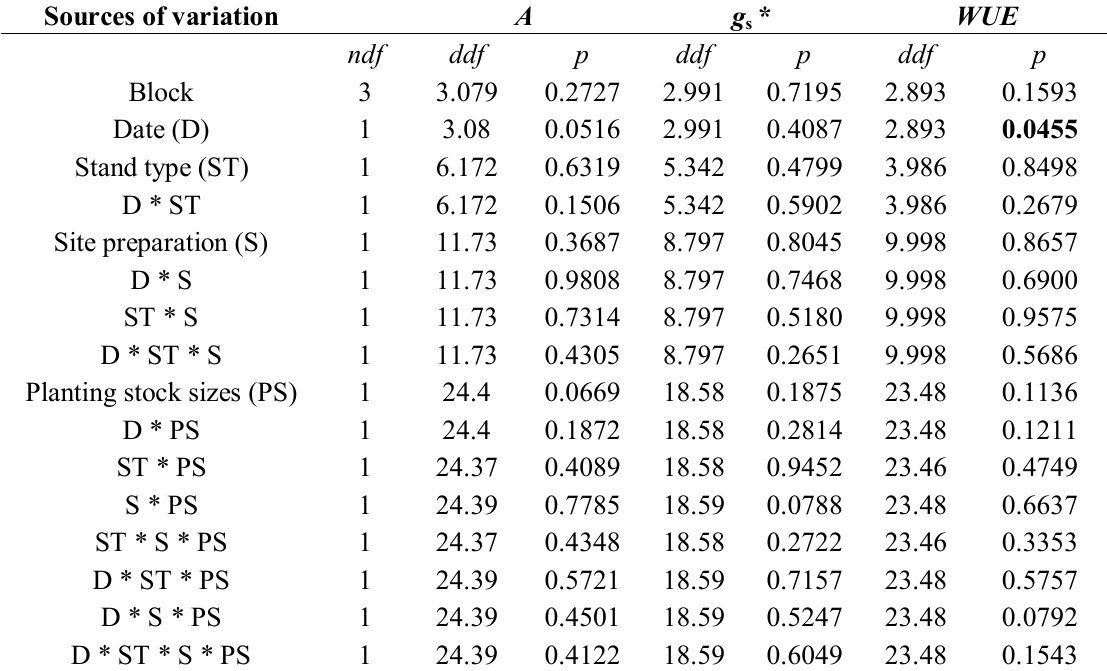
Bold indicates significance ( p ≤ 0.05); ndf = numerator degrees of freedom; ddf = denominator degrees